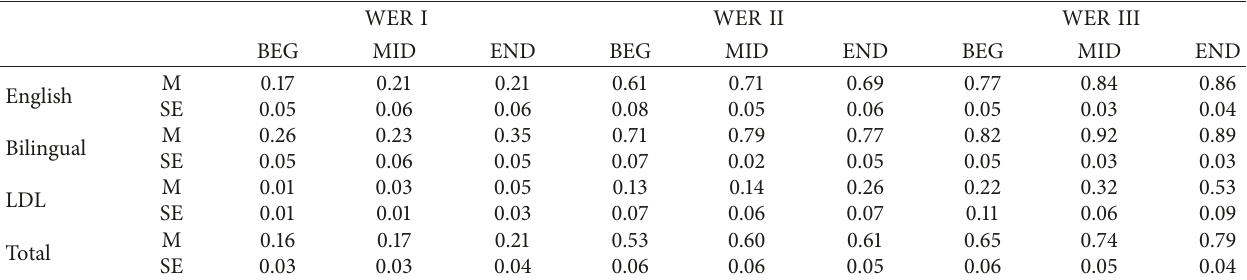
Table 3: Means (M) and standard errors (SE) for word efficiency ratio (WER) at the beginning, middle, and end of the year by language